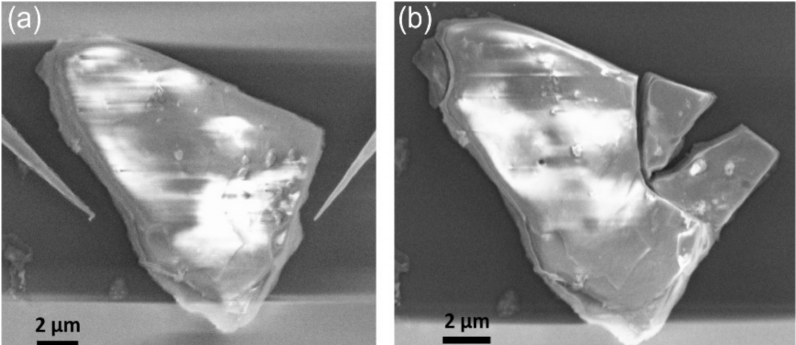
Figure 3. ( a ) SEM of a charged methyl-terminated germanane microcrystallite which is manipulated with two STM tips. ( b ) The right top corner of the microcrystallite was broken, producing two smaller and stable microcrystallites under electron